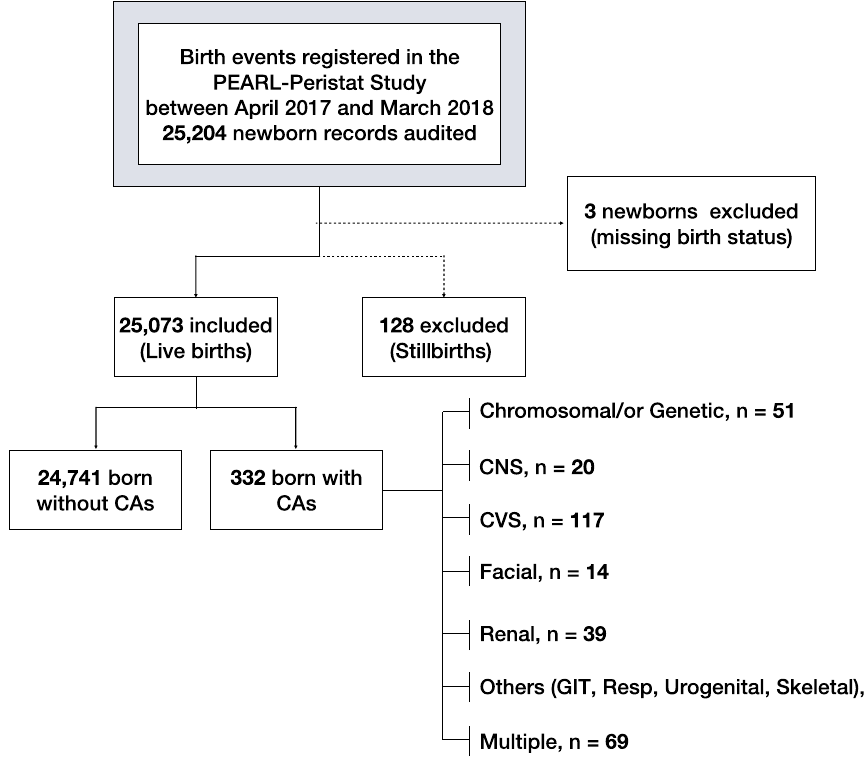
Figure 1. Flow diagram of study sample size of the population-based retrospective of registry data retrieved from the PEARL-Peristat study between April 2017 and March